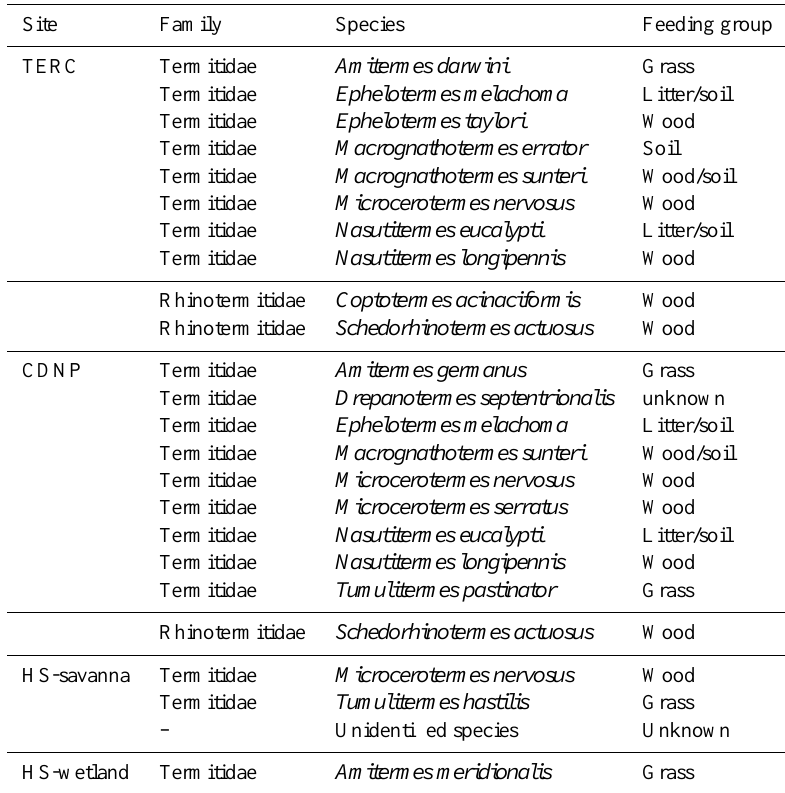
Table 2. List of mound-building termite species collected from the 50m × 50m plots at four